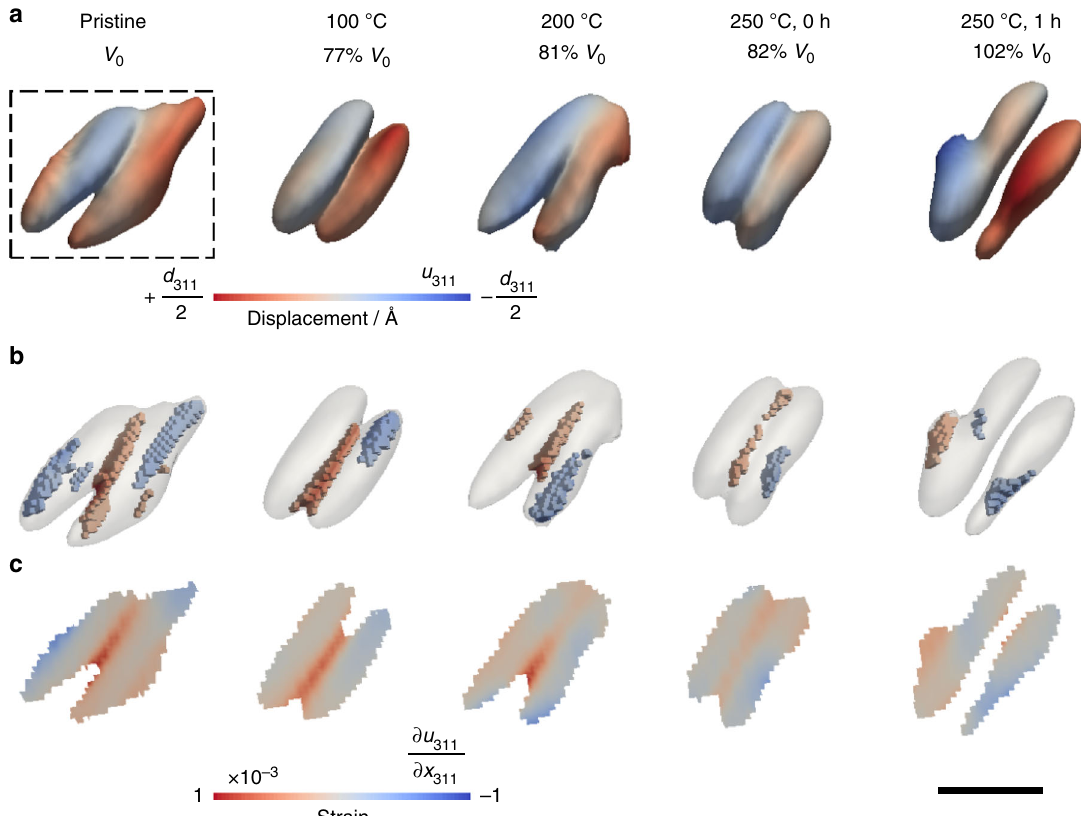
Fig. 6 In situ heating of a twinned magnetite crystal up to 250 °C in air. a 3D volume views at a 30% amplitude threshold with lattice displacement along the [311] direction projected on the isosurfaces. b 3D strain structures corresponding to compressive (blue, strain < − 0.00035) and tensile (red, strain > 0.00035) strains. c Cross-sectional views of the internal strain fi eld at the dashed line box in a . Scale bar, 200